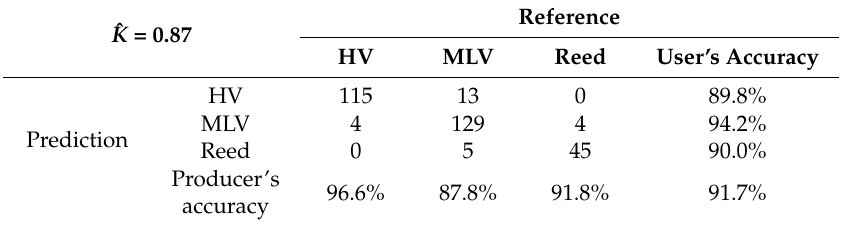
Table 8. Confusion matrix of the RF model using all of the bands (RF model 5). ˆ K = 0.87